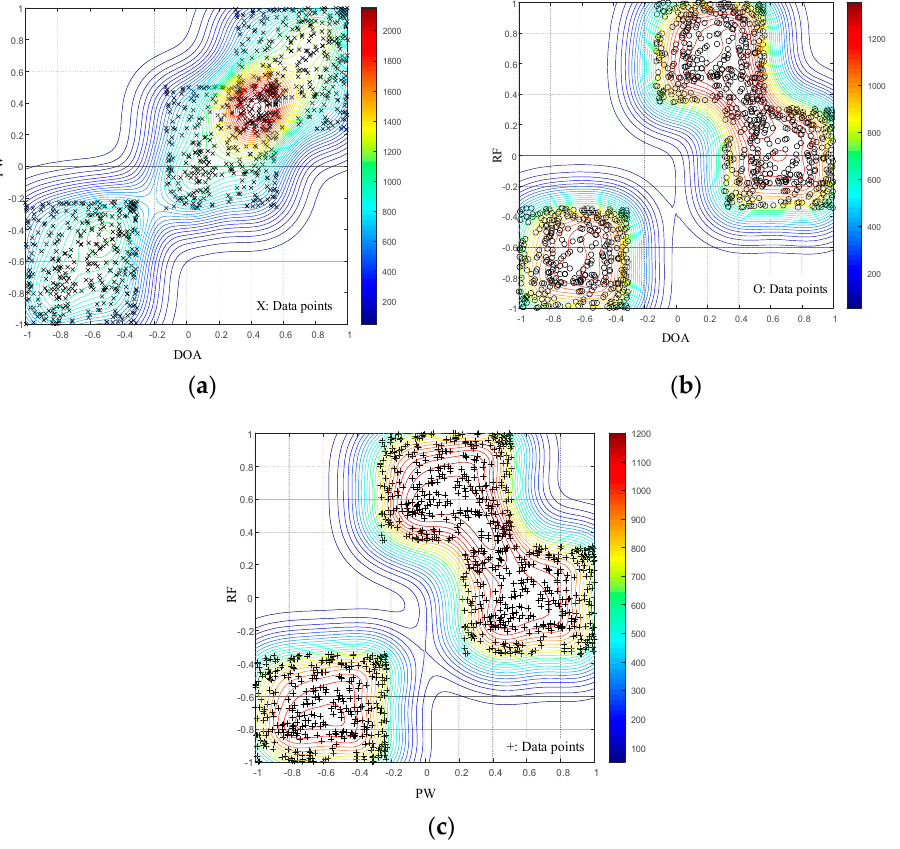
Figure 5. Two-dimensional distribution of signal parameter’s equipotential lines without three-dimensional pseudo-center wide-agile composite modulation. ( a ) Two-dimensional diagram of the PW-DOA equipotential line. ( b ) Two-dimensional diagram of the RF-DOA equipotential line. ( c ) Two-dimensional diagram of the RF-PW equipotential line.